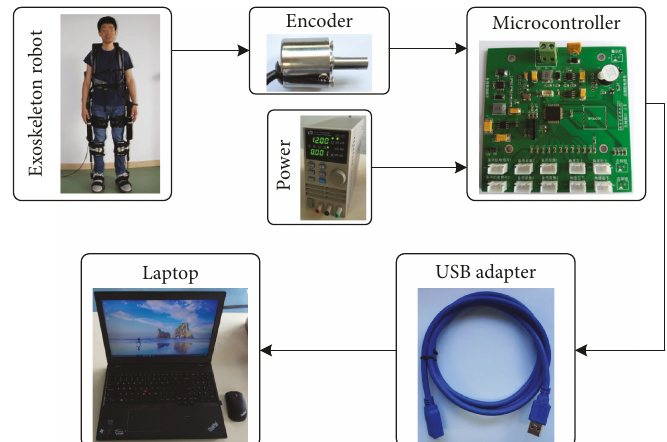
Figure 4: Schematic of the whole data collection system.